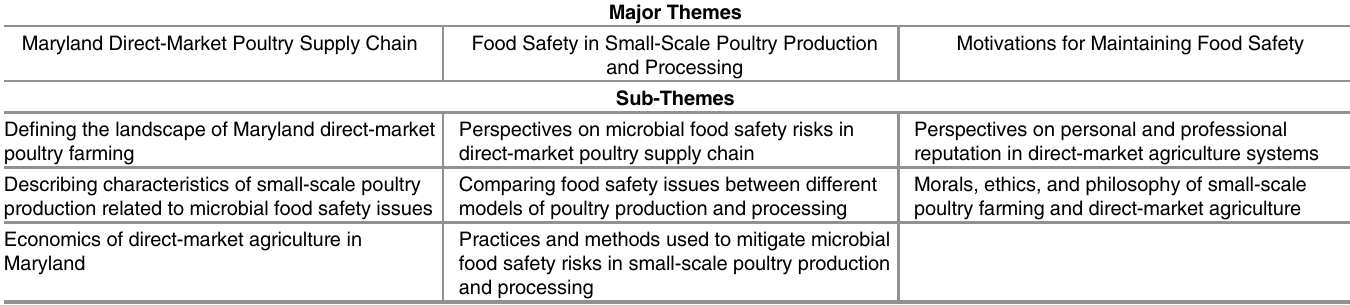
Table 1. Topics and Issues Raised During In-Depth